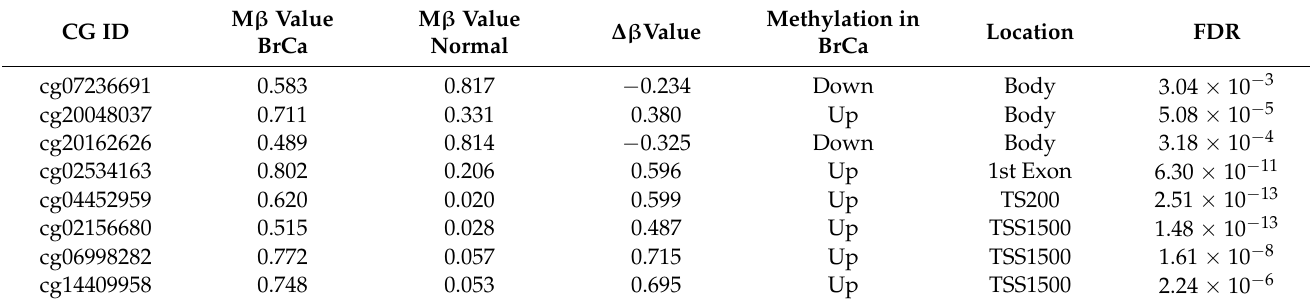
Table 5. ENPP2 DMCs identified in ccfDNA of BrCa patients and healthy individuals via in silico analysis.